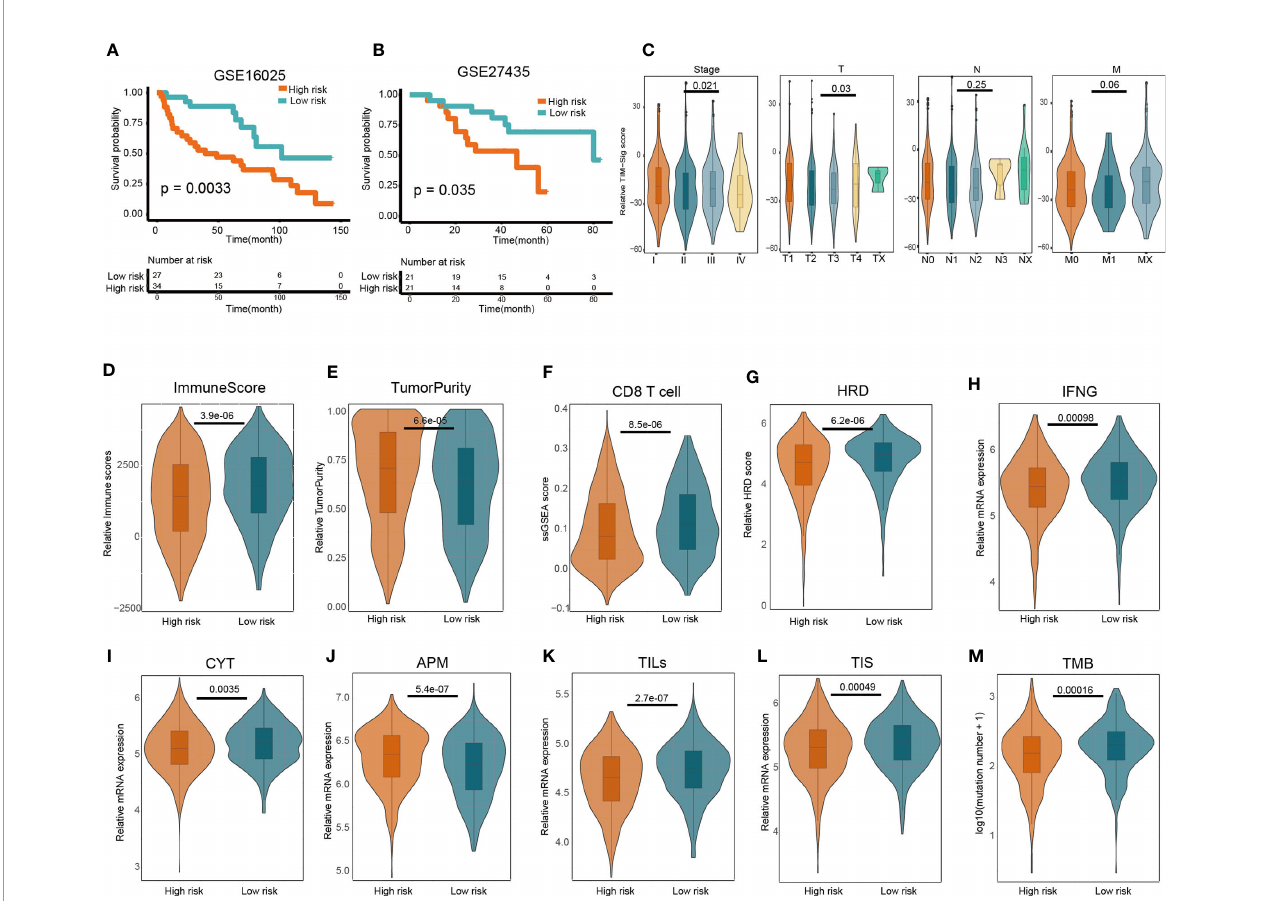
FIGURE 2 | Predictive value of the 10-miRNA signature in NSCLC patients and heterogeneous immune in fi ltration in high- and low-risk groups. (A, B) Kaplan – Meier predictions of patient overall survival in those of low- or high-risk as strati fi ed using the TIM-Sig (GSE16025 and GSE27435). The log-rank test was used to carry out statistical analysis. (C) The difference of TIM-Sig score in clinical classi fi cation (include stage and TNM classi fi cation). (D) Relative immune scores between low- and high-risk cohorts. (E) Comparison of relative tumor purity between low- and high-risk cohorts. (F) Comparison of relative CD8 T cell score based on ssGSEA between low- and high-risk cohorts. (G) Comparison of relative chromosomal instability level between low- and high-risk cohorts. (H) Comparison of relative IFN- g expression signature between low- and high-risk cohorts. (I) Comparison of relative cytotoxic activity scores between low- and high-risk cohorts. (J) Comparison of relative antigen presentation machinery between low- and high-risk cohorts. (K) Comparison of relative tumor-in fi ltrating lymphocytes between low- and high-risk cohorts. (L) Comparison of relative T cell in fi ltration score between low- and high-risk cohorts. (M) Comparison of relative tumor mutation burden between low- and high-risk cohorts. The p-values were calculated using the Wilcoxon